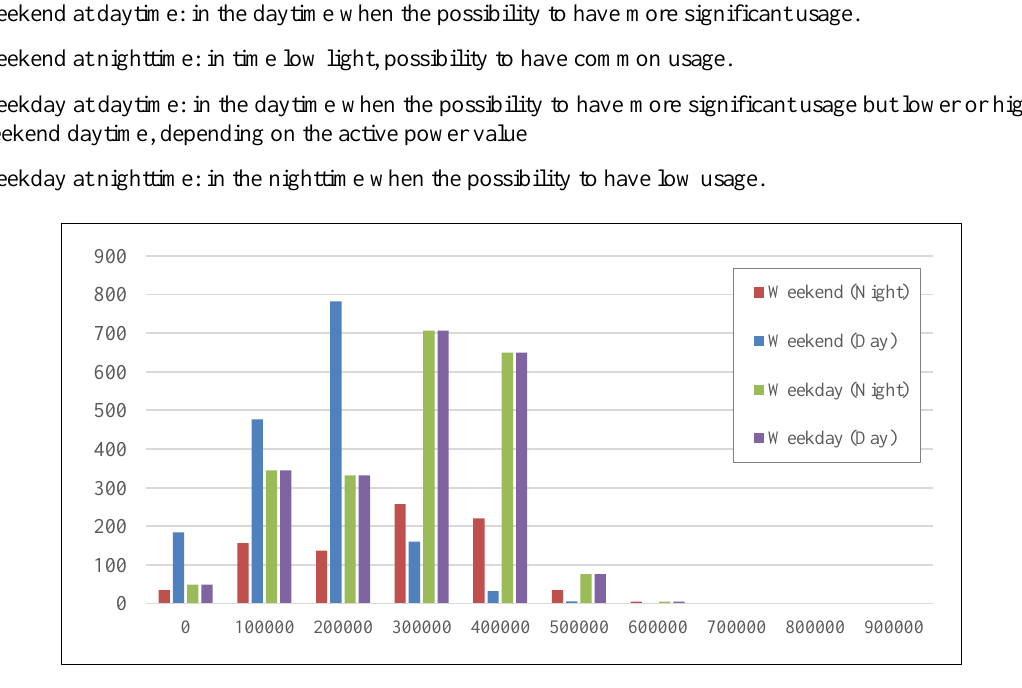
Figure 5. Plotting of weekend/weekday and